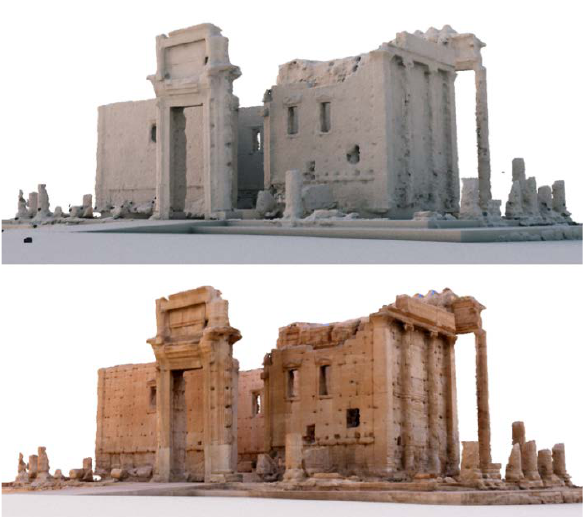
Figure 7. The final model of Bel Temple (untextured: top, textured: